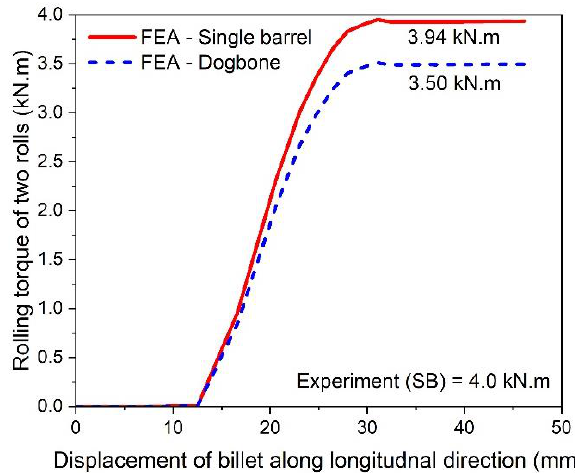
Figure 14. Variation of rolling torque with billet displacement for single and double barrel.